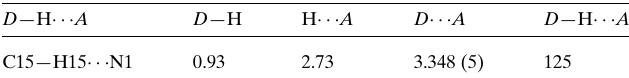
Table 2 Experimental details.